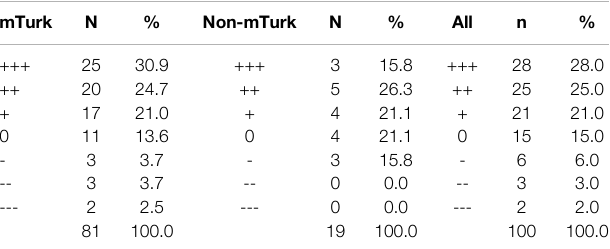
TABLE 6 | Overall effectiveness of the